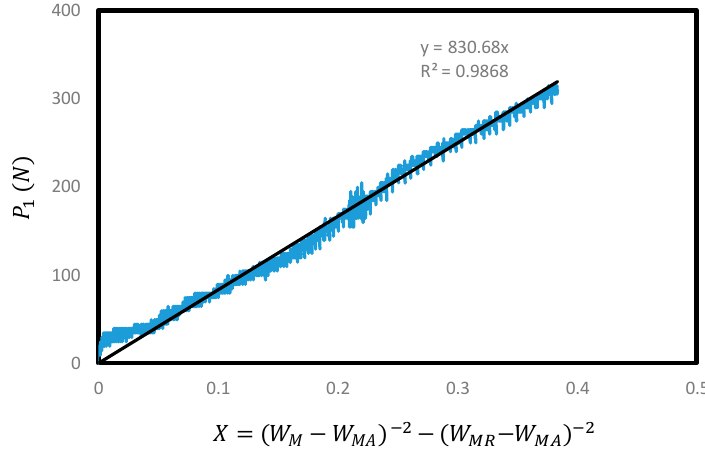
Figure 7. Estimation of far tail constant, A .